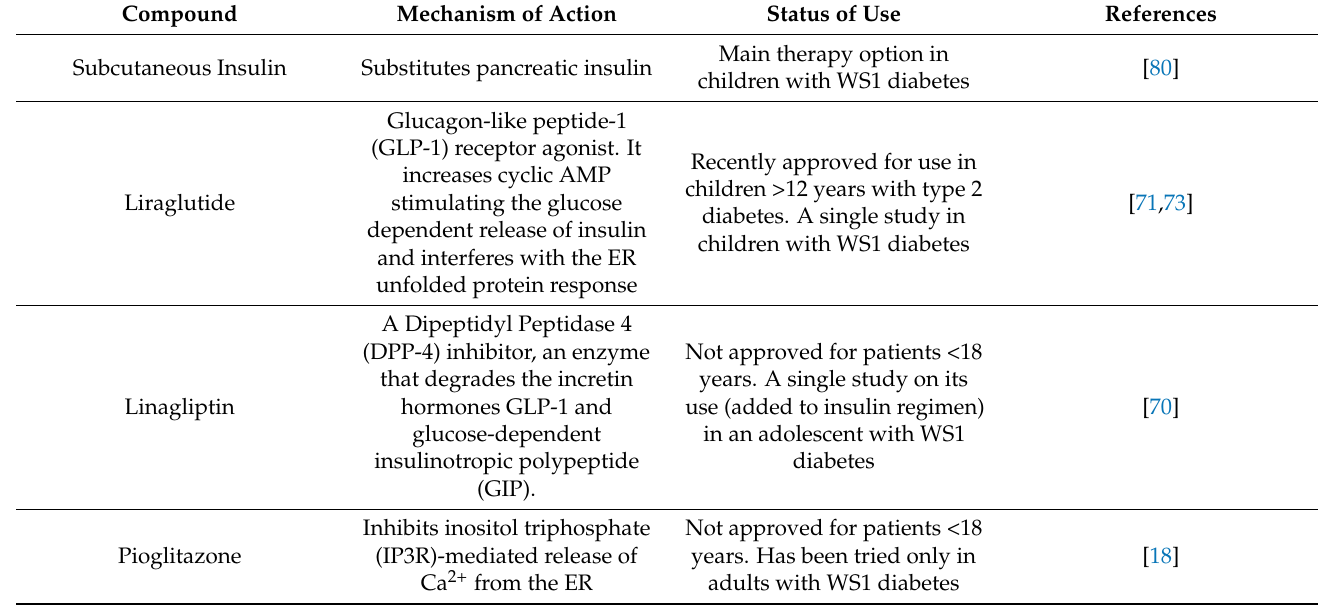
Table 3. Drugs used to treat diabetes in young patients with Wolfram syndrome